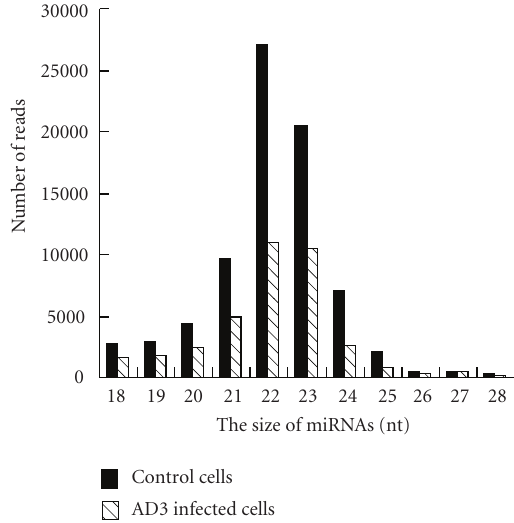
Figure 1: Size distribution of sequenced miRNAs.